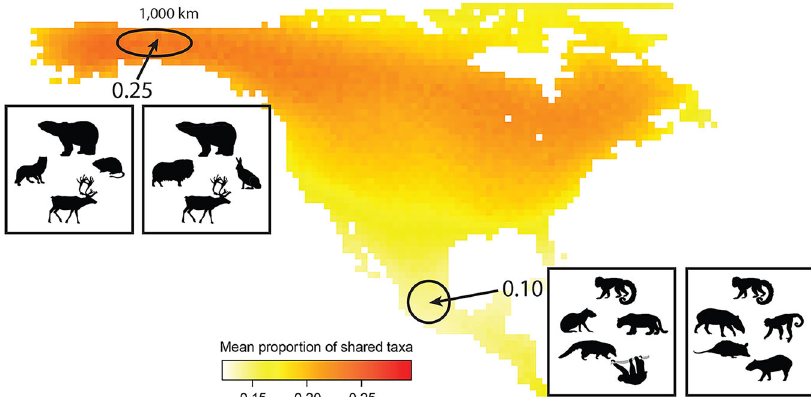
Fig. 4 Latitudinal patterns of mean taxonomic similarity for modern Western Hemisphere mammals measured as mean proportion of shared taxa (Jaccard similarity) (sample sizes in Source Data). An increase of 0.15-0.25 in assemblage similarity between ~15,000 ybp and Modern for North American mammals is equivalent to the difference in mean similarity between assemblages in Alaska and the same-sized regions in the subtropics at ~30 ˚ of latitude. The value of each cell is the mean Jaccard similarity of all surrounding cells within a 1000 km radius. Mean similarity between cells is 2.5× higher for Alaskan than for Mexican communities. Circles represent hypothetical assemblages of mammals from Arctic Alaska and Mexico. Silhouettes represent the occurrences of different species in adjacent grid cells. Silhouette credits from phylopic.org: Sarah Werning ( Bradypus , Cebinae), Rebecca Groom ( Nasua ), Lukasiniho ( Panthera ). Silhouettes are distributed under Creative Commons Attribution 3.0 Unported